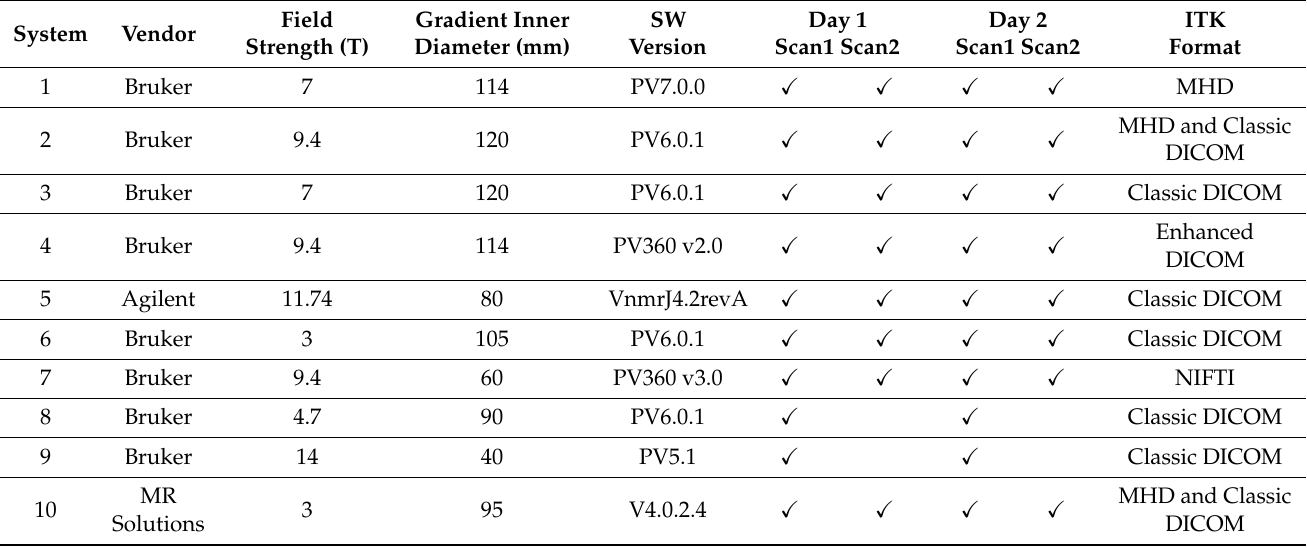
Table 1. MRI system demographics and data